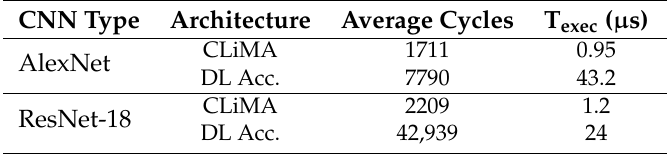
Table 2. Performance estimation of CLiMA with respect to the Deep Learning Accelerator for AlexNet and ResNet-18 when the parallelism is 10. For both architectures the working frequency is 1.8